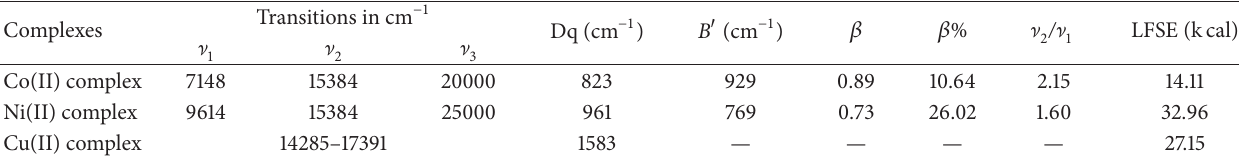
Table 4: Electronic spectral bands and ligand field parameters of the Co(II), Ni(II), and Cu(II) complexes in DMF (10 −3 M) solution.